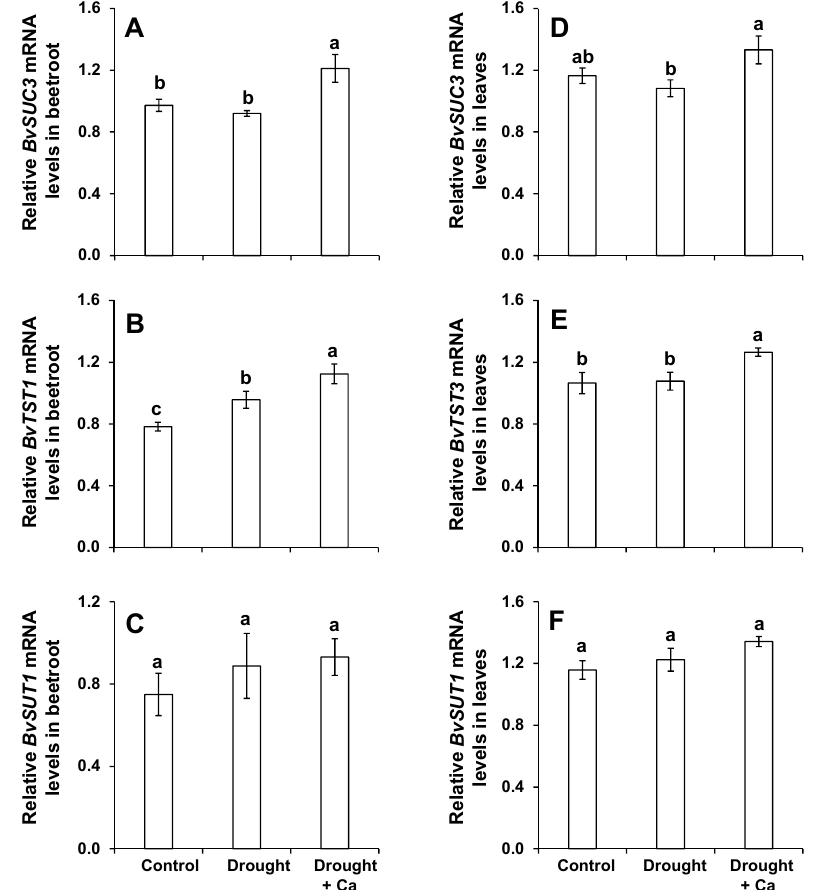
Figure 4. Influence of foliar application of Ca 2 + on the expression levels of the genes involved in sugar transport in sugar beet plants exposed to drought stress. ( A ) Relative BvSUC3 mRNA levels in beetroot; ( B ) relative BvTST1 mRNA levels in beetroot; ( C ) relative BvSUT1 mRNA levels in beetroot; ( D ) relative BvSUC3 mRNA levels in leaves; ( E ) relative BvTST3 mRNA levels in leaves; and ( F ) relative BvSUT1 mRNA levels in leaves. Plants were grown in pots for a duration of 8 weeks. Five-week-old sugar beet plants were kept at 90% field capacity as control or exposed to drought stress (30% field capacity) for a duration of 3 weeks. Ca 2+ was applied at BBCH14 and BBCH18 in concentration of 5 L ha − 1 corresponding to 540 g Ca ha − 1 . Leaves and beetroot were harvested at 60 days after sowing for gene expression analysis. Bars indicate means ± SEM. Di ff erent letters denote significant di ff erences according to ANOVA followed by SNK test ( p < 0.05; n =